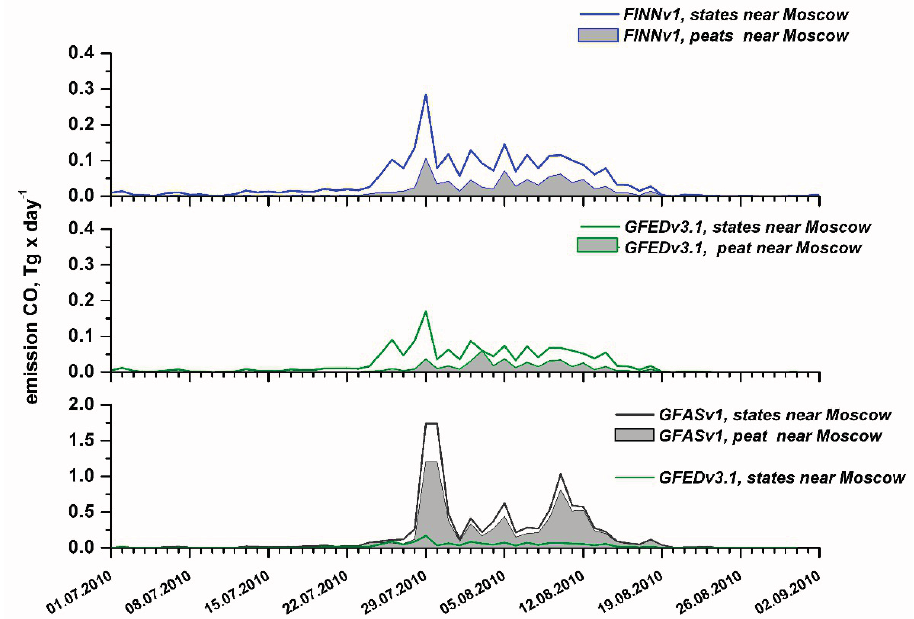
Figure 11. Daily CO emissions from wildfires in the central part of Russian plain between 1 July 2010 and 1 September 2010. The emission values are taken from FINNv1, GFEDv3.1 and GFASv1 datasets. The grey background color corresponded to peat areas (hatch areas in Figure